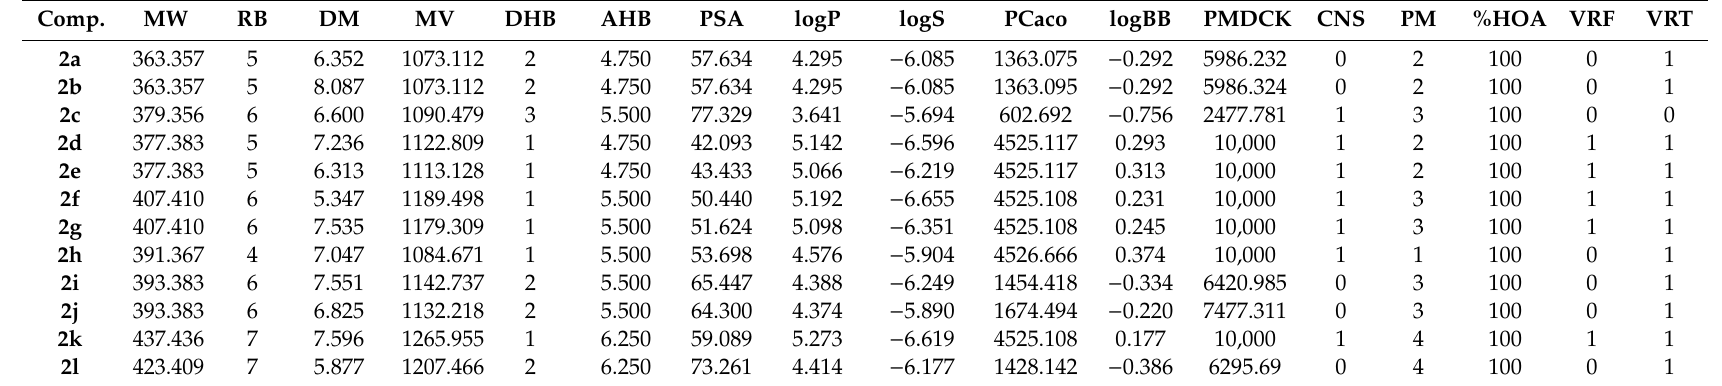
Table 2. Calculated ADME (absorption, distribution, metabolism, elimination) parameters of compounds 2a – 2l .